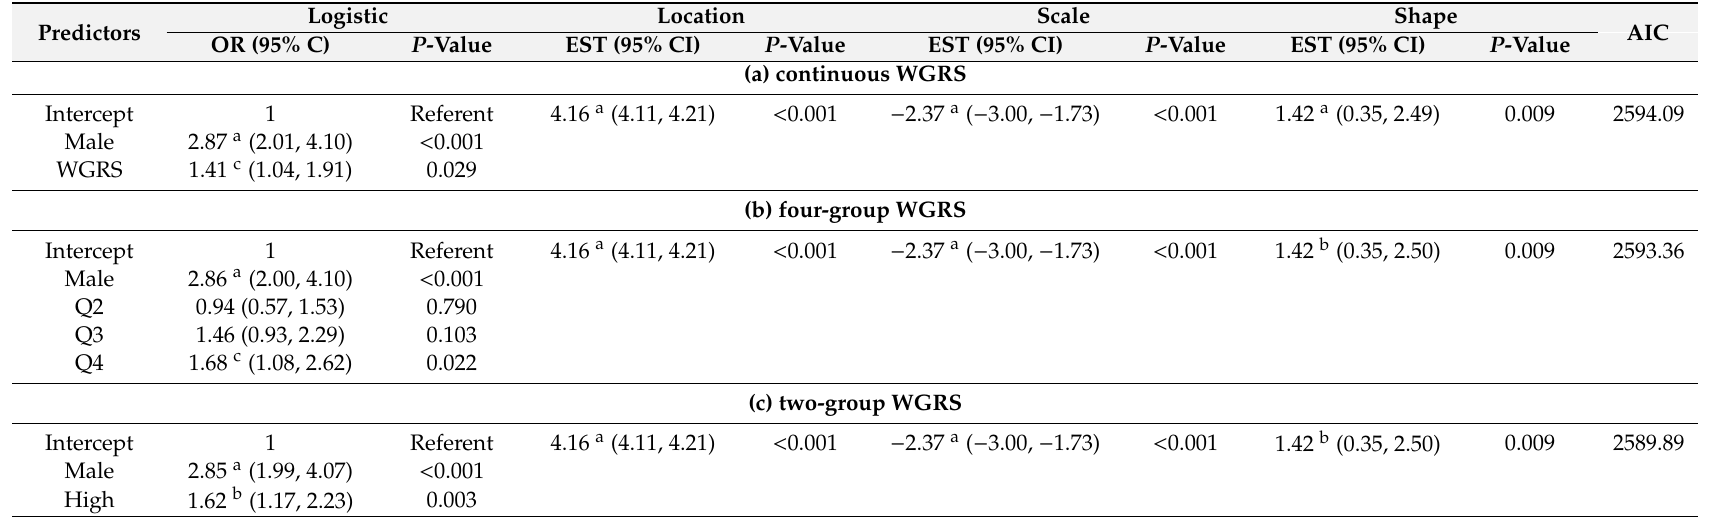
Table 4. Optimally fitted logistic-GGD location–scale mixture regression models relating cardiovascular disease (CVD) events to sex and the WGRS. Logistic Location Scale Shape